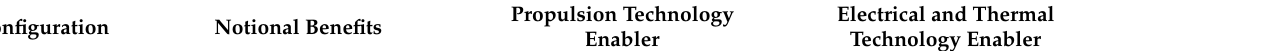
Table 8. Propulsion system technology enablers and research